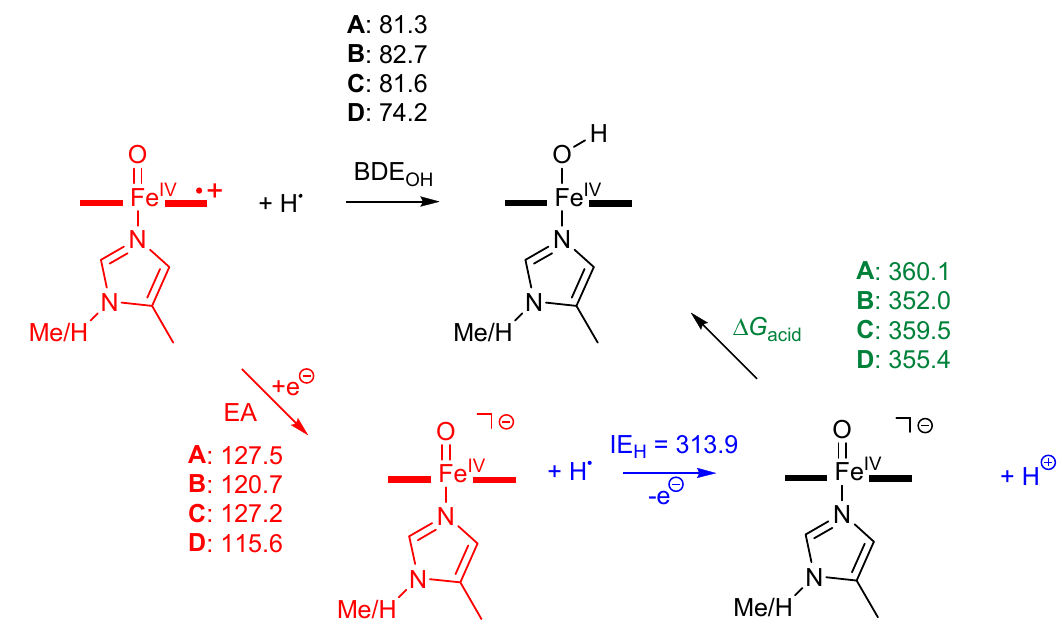
Figure 6. UB3LYP / BS2 // UB3LYP / BS1 + ZPE + E solv calculated thermochemical properties of reactant complexes A , B , C , D with energies in kcal mol − 1 . The bold horizontal bars represent the porphyrin ring.